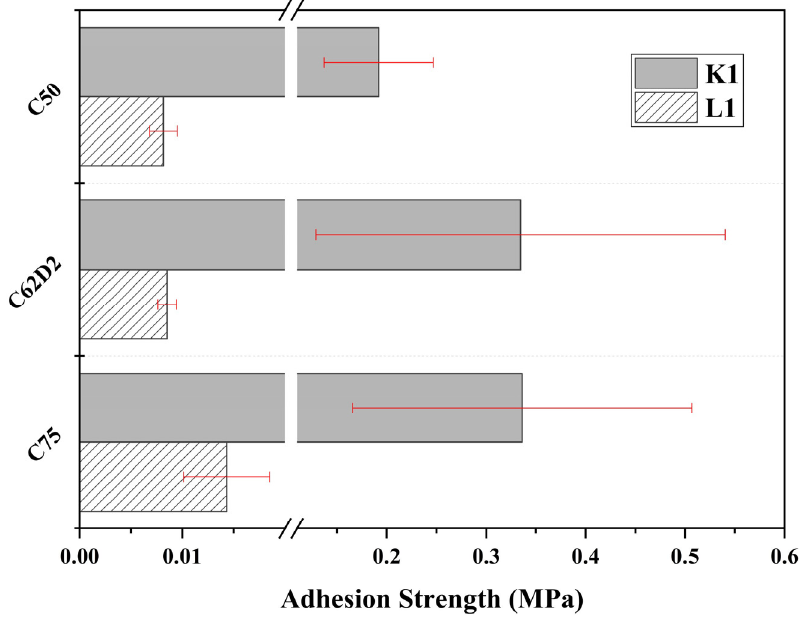
Figure 7. A comparative plot of the adhesion strength analyses on L1 and K1 joints based on the pull-off adhesion tests.